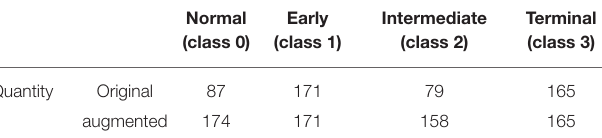
TABLE 1 | Distribution of